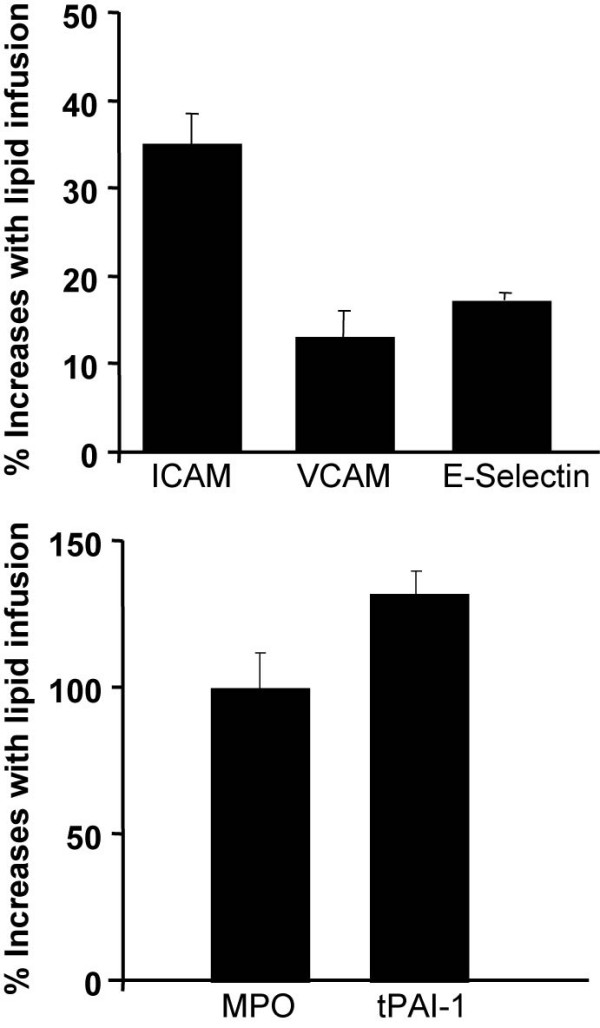
This figure summarizes the percent increase with lipid infusion of markers of endothelial activation, MPO and tPAI-1